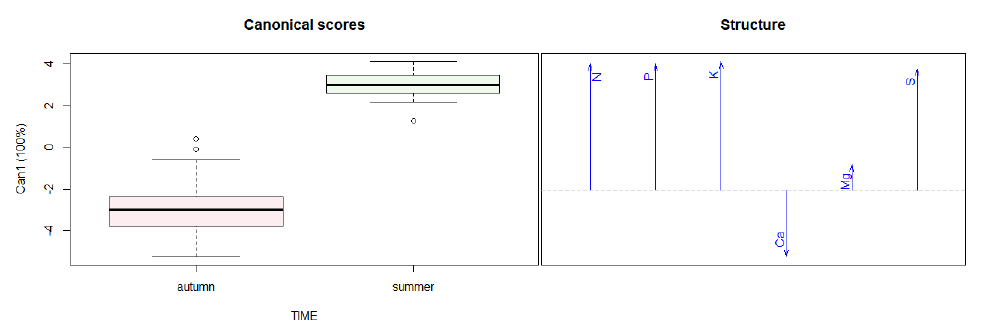
Figure 3. Discriminant canonical analysis on macronutrient content (mg cm −2 ) in summer and autumn leaves. Data from both cultivars were included. Bar charts ( left ) of discriminant functions and arrows ( right ) represent the direction of each parameter analysed.